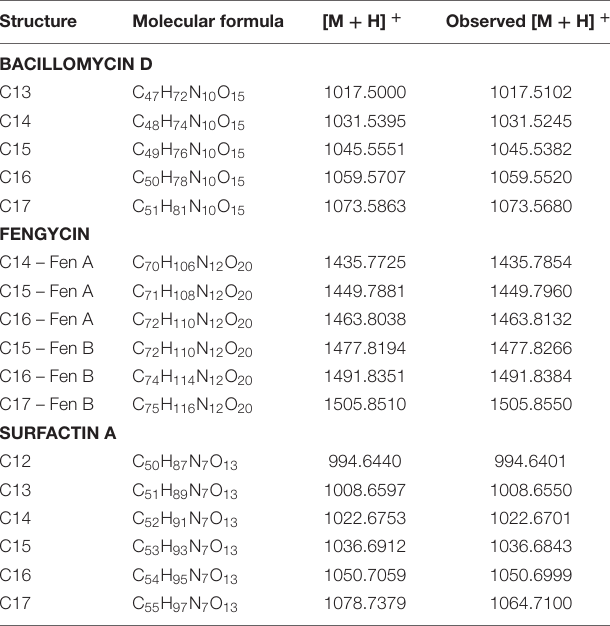
TABLE 2 | Lipopeptide identified in Bacillus sp. M21a. Structure Molecular